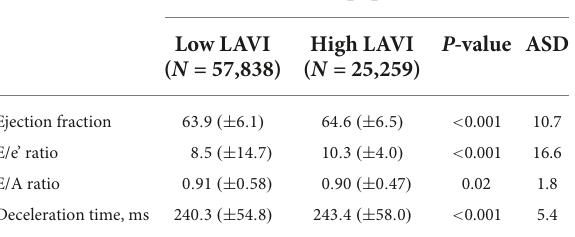
TABLE 2 Echocardiographic parameters.